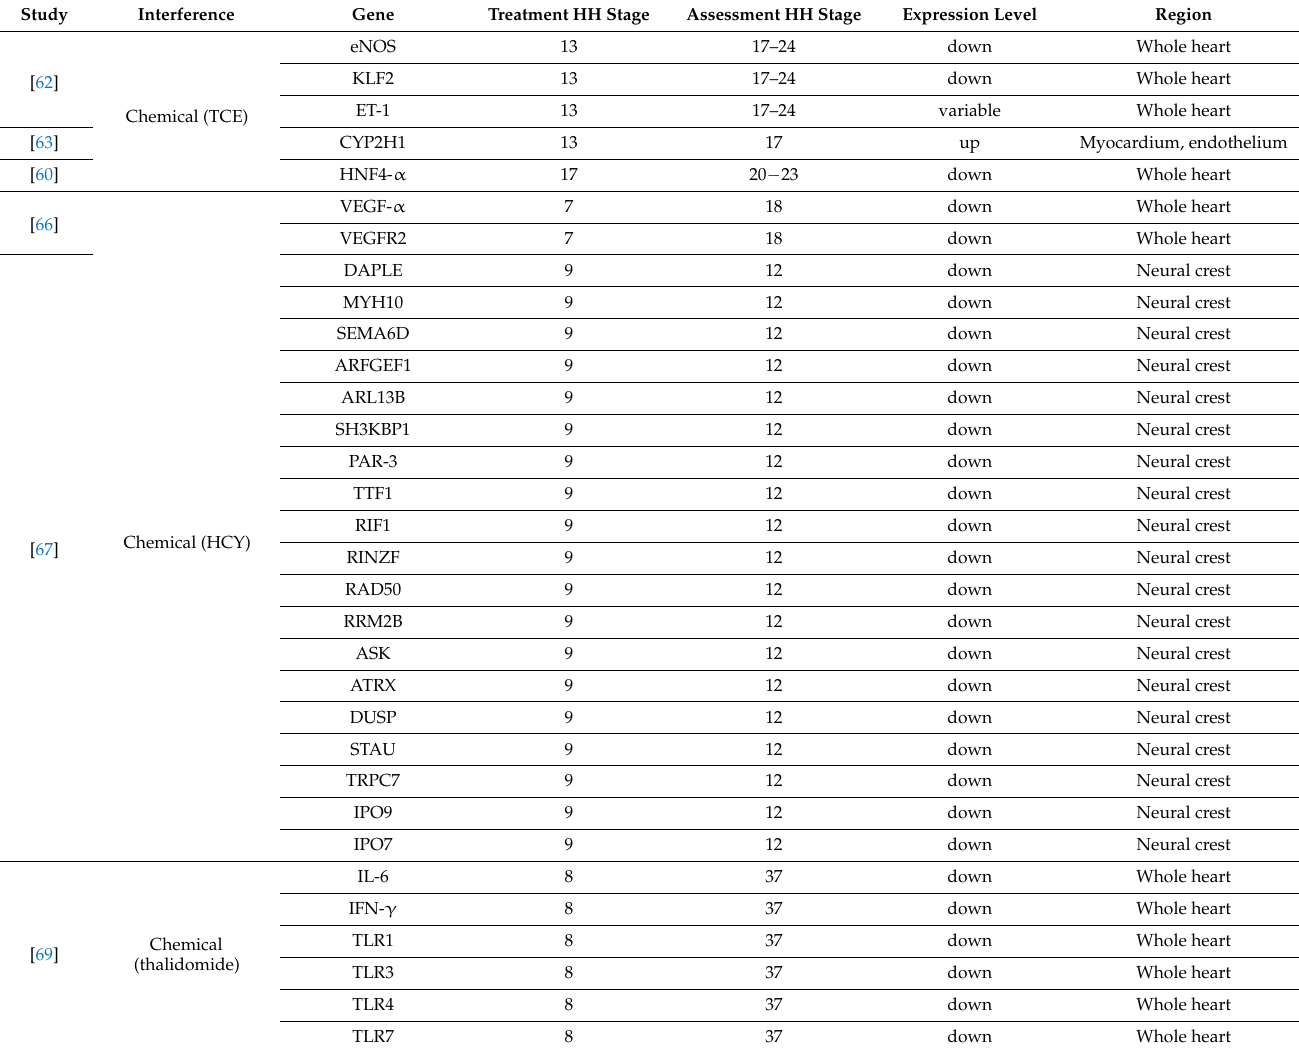
Table 2. Summary of chemical interventions and the genes they up/down-regulate in the embryonic chick specific heart